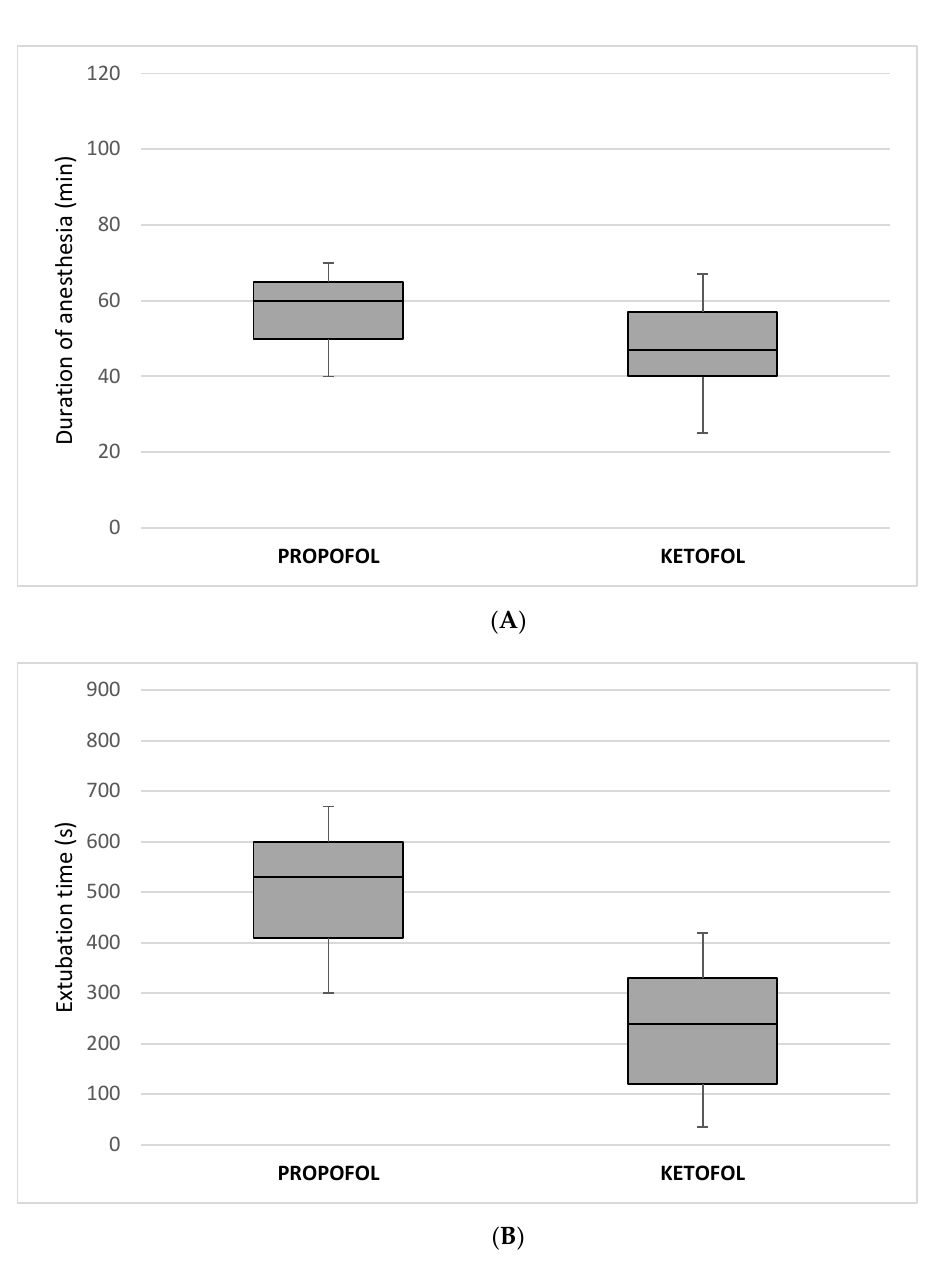
Figure 1. Comparison of ( A ) duration of anesthesia and ( B ) extubation times between the propofol and the ketofol groups. Total fentanyl (100 µg (IQR 80, 125) vs. 50 µg (40, 60); p < 0.00001) (Figure 2A) and propofol (260 mg (IQR 200, 350) vs. 160 mg (IQR 120, 210); p < 0.00001) (Figure 2B) consumption per body weight were significantly lower in the ketofol group than in the propofol group.